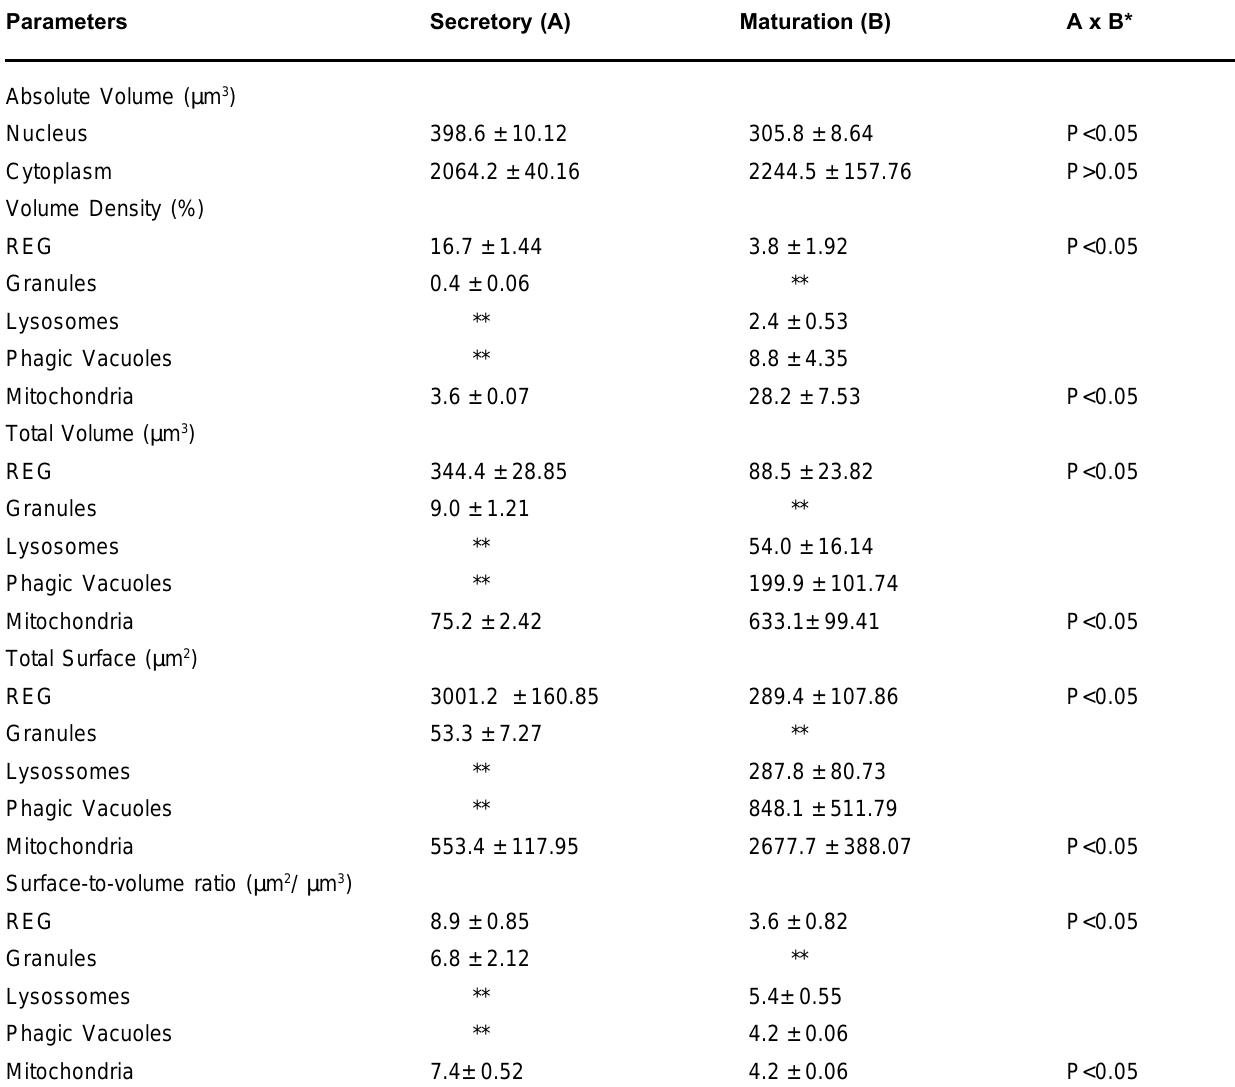
TABLE 1 - The mean and standard deviation of morphometric parameters of the secretory and maturation